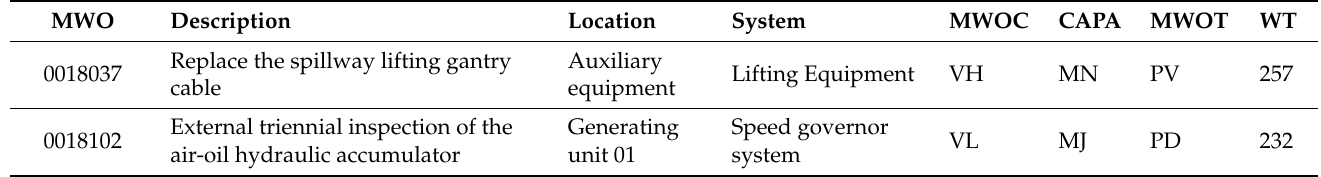
Table 1. Database of maintenance work orders (MWO) and their performance in each